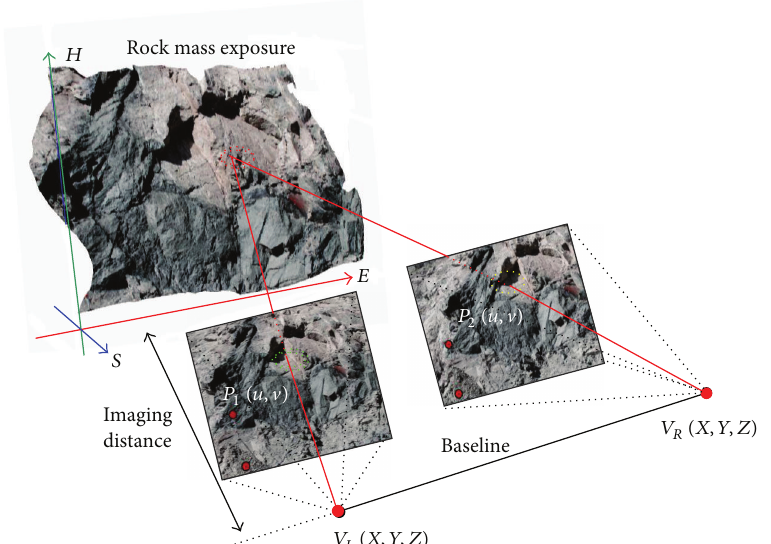
Figure 1: Imaging principle of the 3D surface measurement.